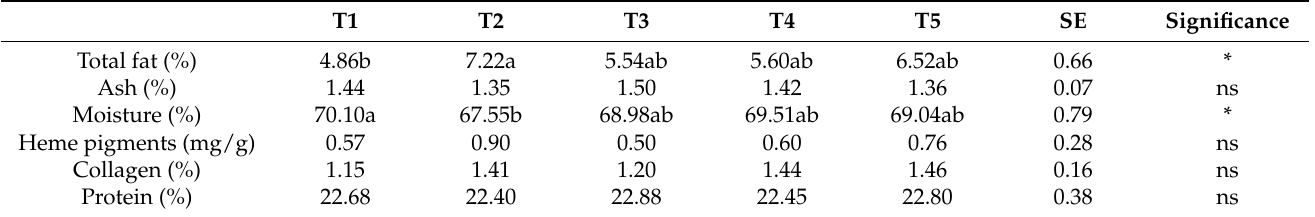
Table 4. Chemical composition of Longissimus thoracis et lumborum muscle. Effect of treatment with olive